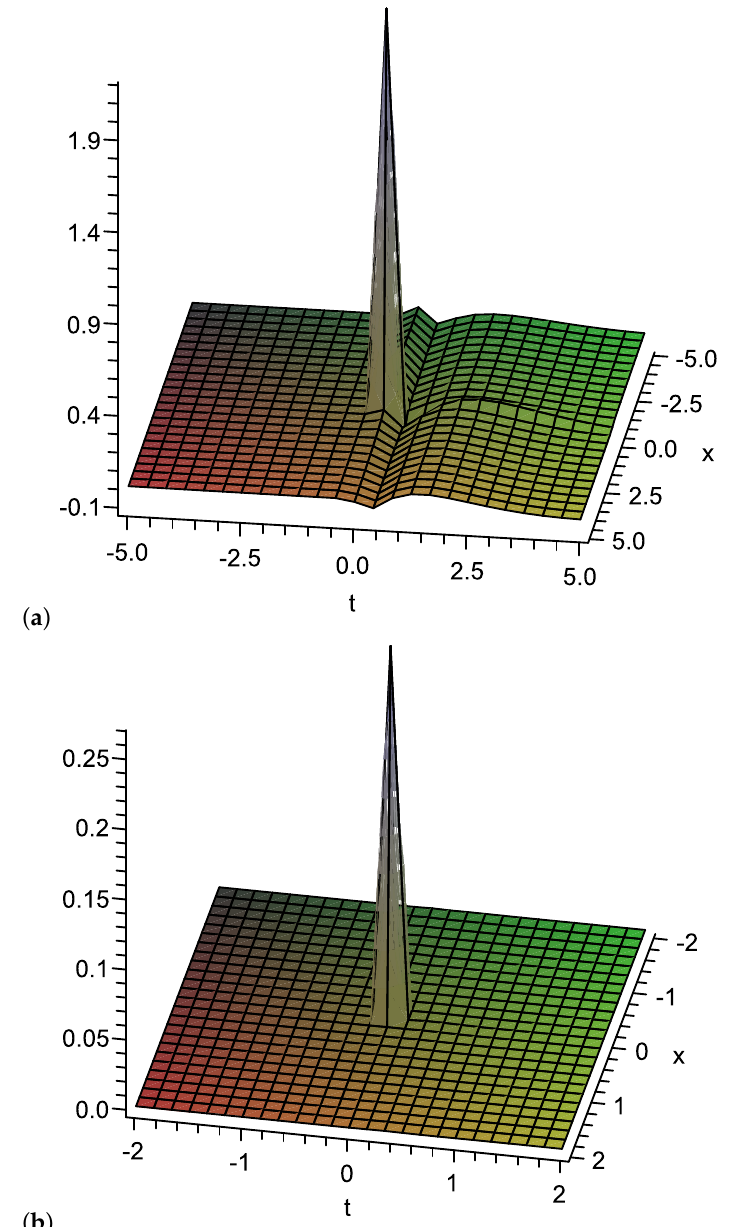
Figure 1. The first moment for the random solution sq 1 in (49); α is a beta random variable and − 2 ≤ t , x ≤